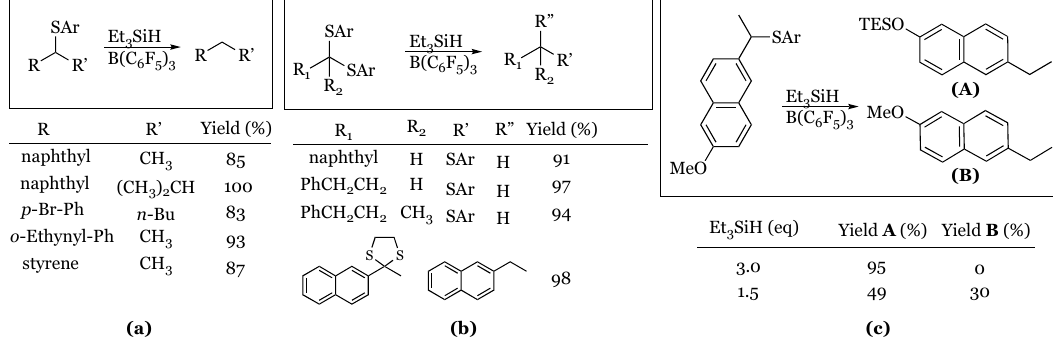
Figure 7. Hydrodesulfurization of carbon-sulfur bonds: ( a ) sulfides; ( b ) dithianes; ( c ) sulfide versus methyl aryl ether competition reactions.